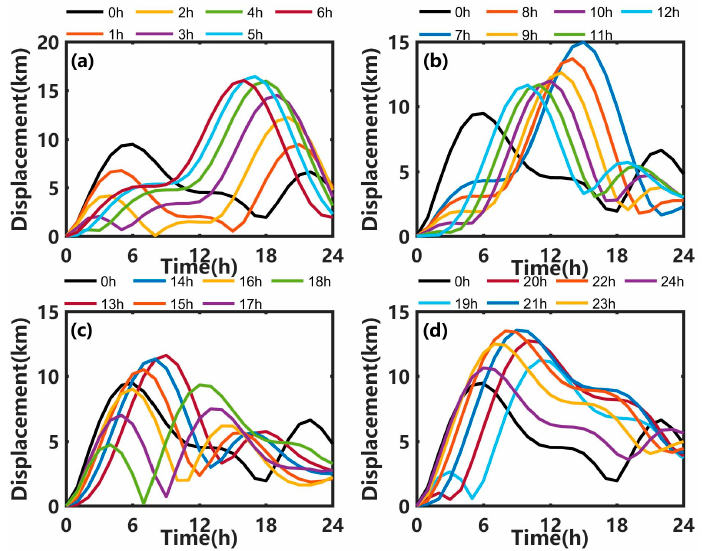
Figure 12. Centroid displacement at the sea surface in Exp1 (black lines) and SE3 when the delay of